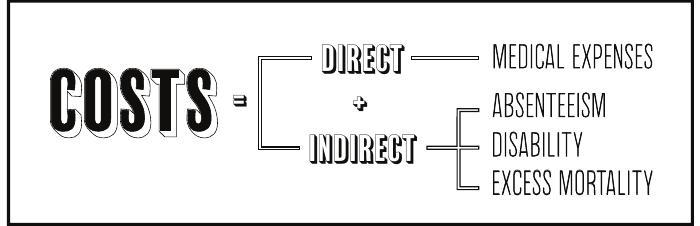
Figure 1. Basic composition of costs for